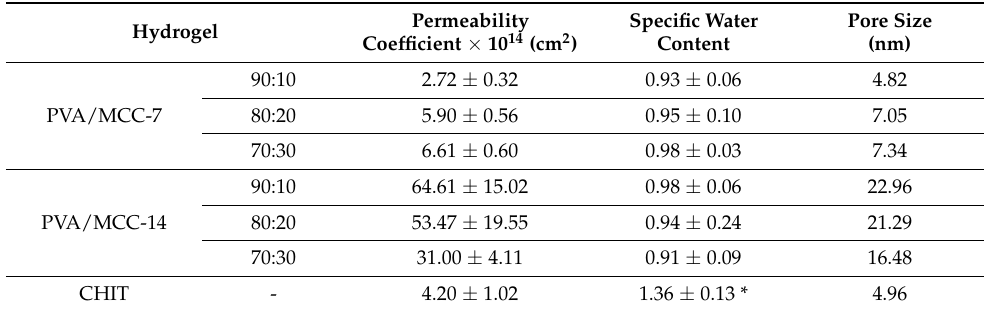
Table 7. Permeability characteristics of hydrogels (mean ± SE; n = 5 for permeability coefficient, n = 3 for specific water